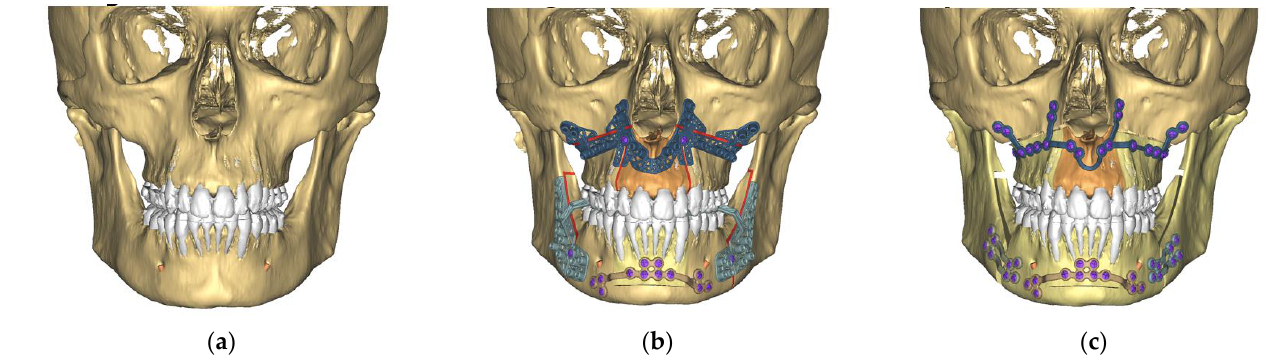
Figure 2. Model of a patient’s head ( a ), virtual planning of the patient-specific guides ( b ), and virtual planning of the patient-specific plates ( c ).